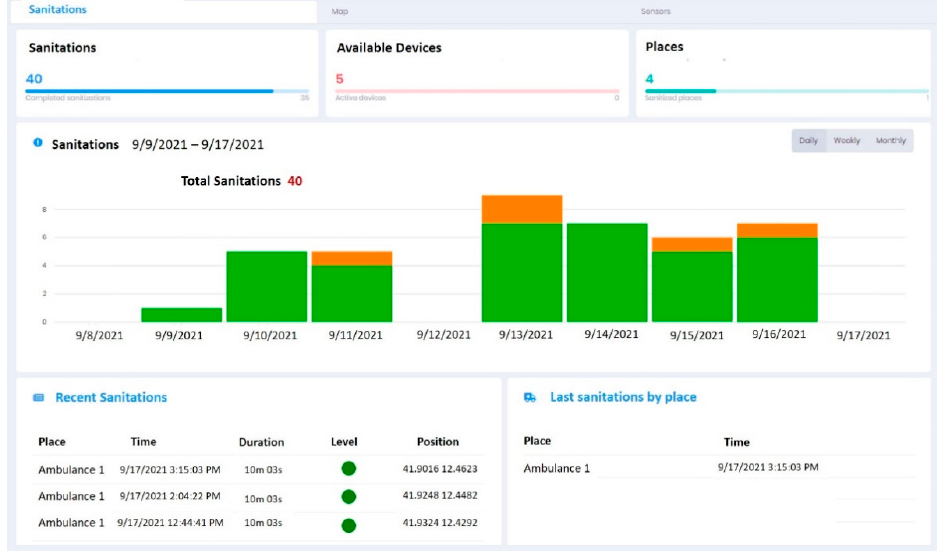
Figure 7. UV-SAN—Dashboard for consultation of sanitation data .